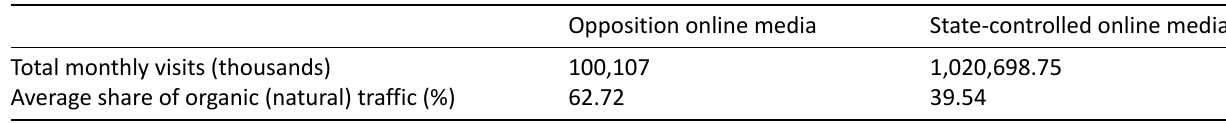
Table 2. Total monthly visits and average share of organic traffic for state‐controlled and opposition outlets in